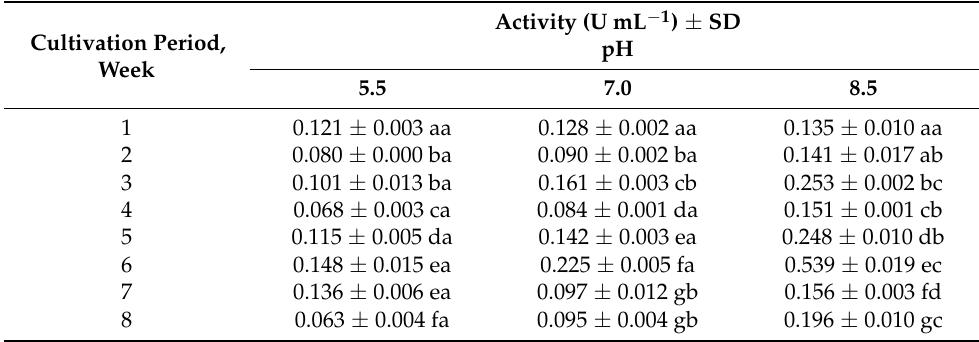
Table 3. Exoglucanase activity of P. melonis 502 under different pH values. Cultivation